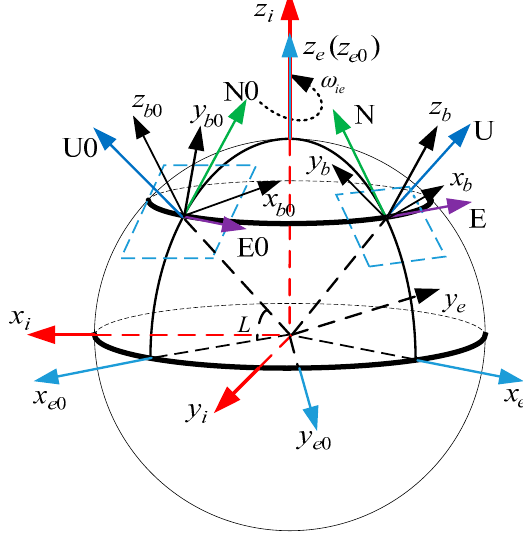
Figure 1. The definition of the coordinate frames.